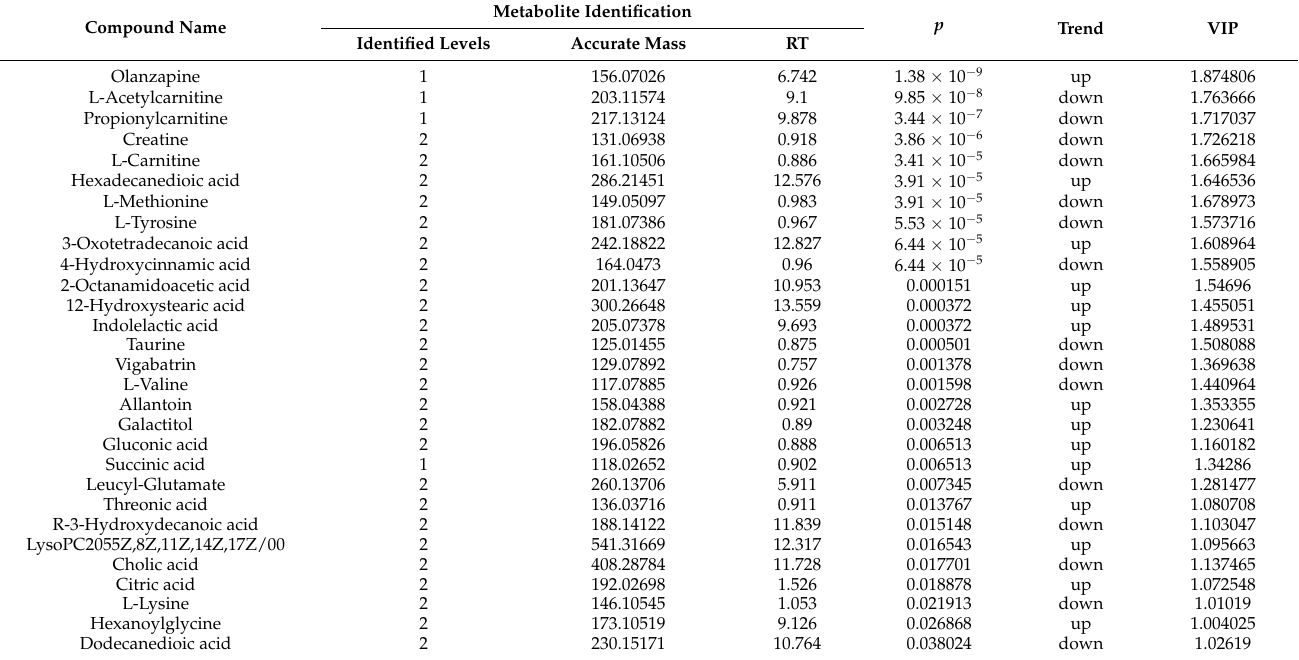
Table 3. Differential metabolites after fatal intoxication by